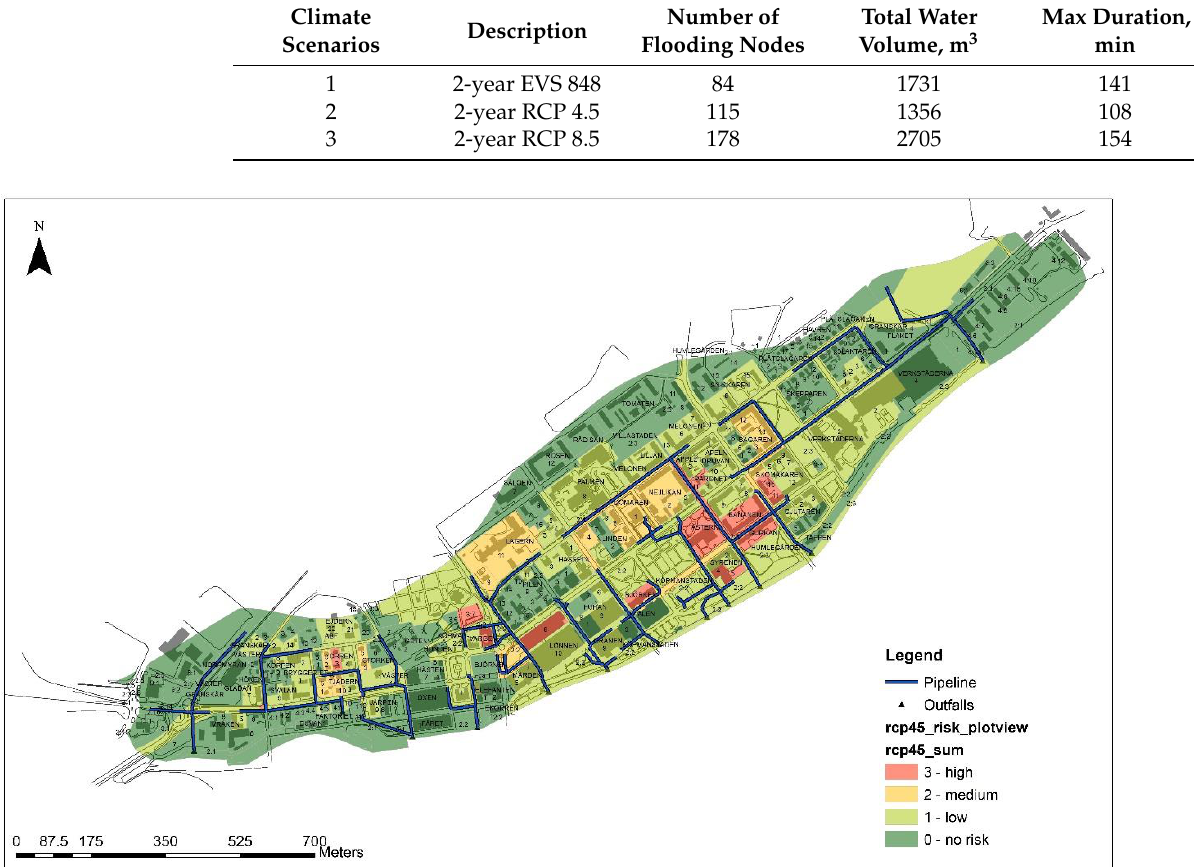
Figure 8. Visual presentation of the EWL. Flooding risk map of Söderhamn; scenario 2.